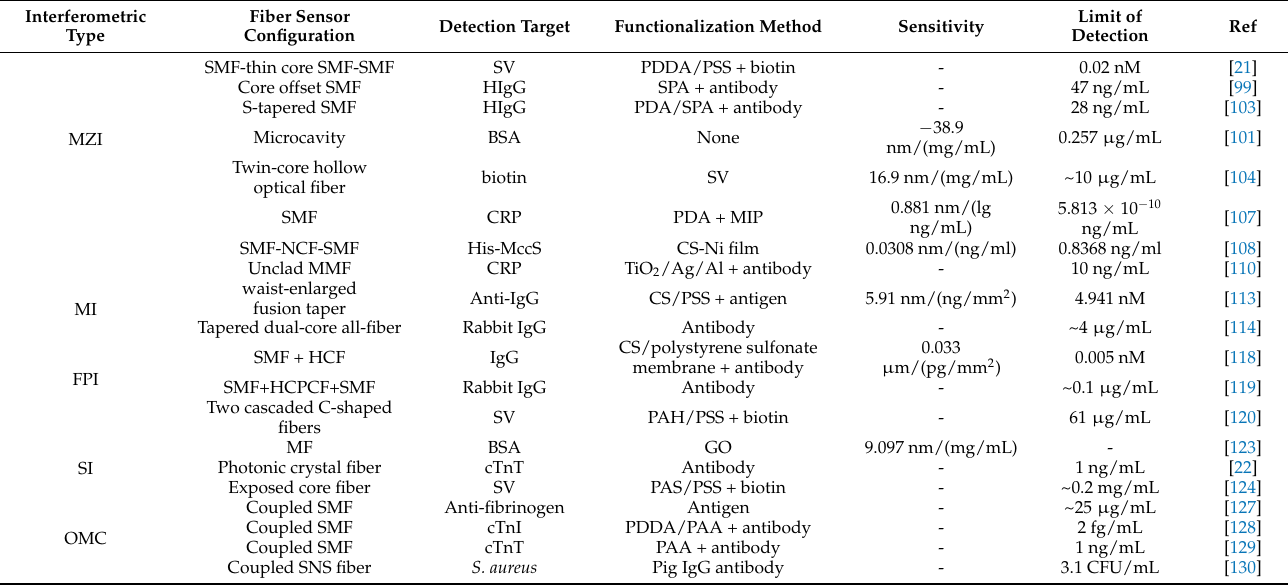
Table 3. Interferometer-based fiber biosensors for protein detection.